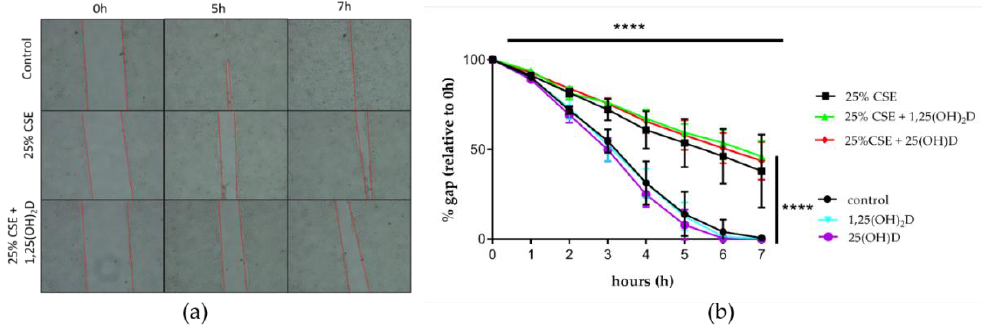
Figure 4. E ff ect of CSE and VitD on wound healing in 16HBE cells. ( a ) Illustration of